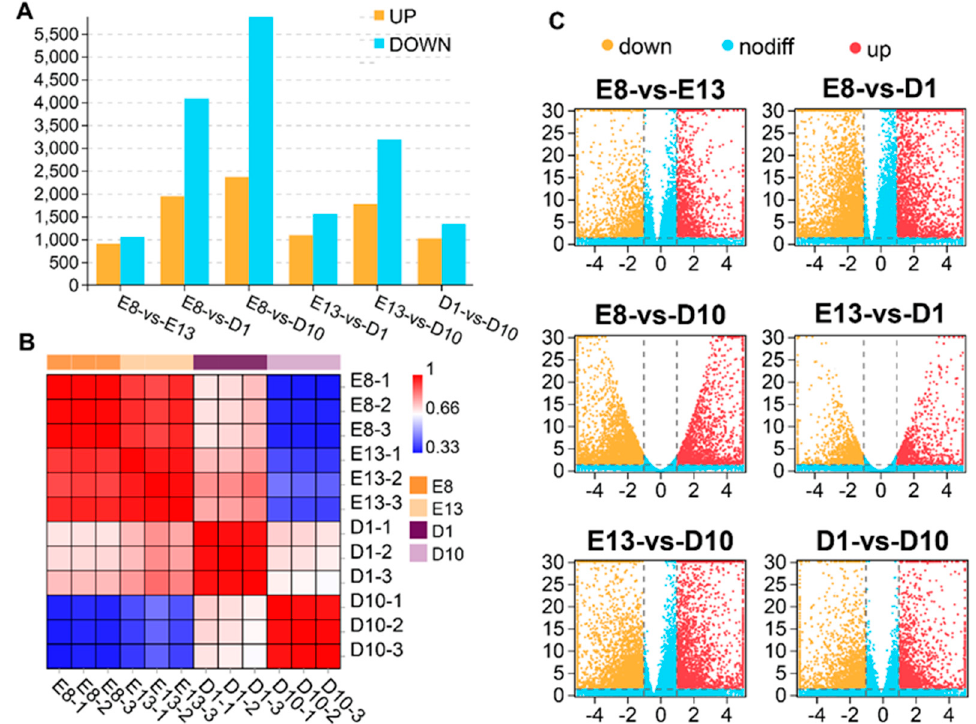
Figure 1. Gene expression pattern analysis. ( A ) Histogram of DEGs among the four stages. Blue represents the number of upregulated genes, and yellow represents the number of downregulated genes. ( B ) Heatmap of correlation between samples based on gene expression. The colours from blue to red represent low to high correlation. ( C ) Volcano plot of differential gene expression analysis. Upregulated genes are marked red, downregulated genes in yellow, and nonsignificant genes in blue,